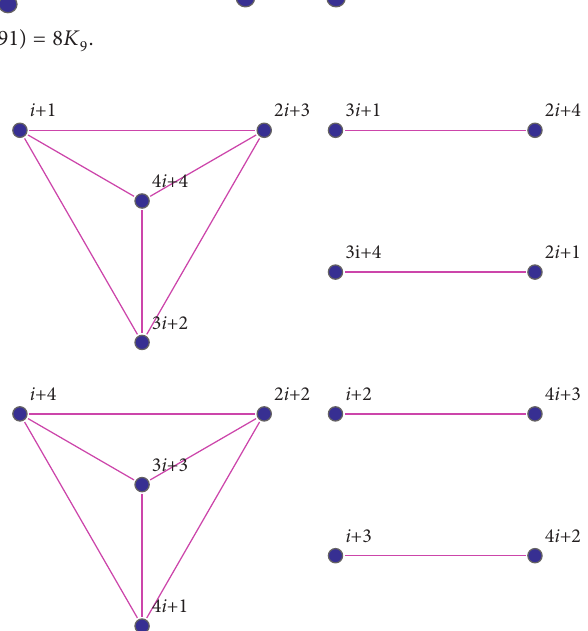
Figure 2: 􏽢 G ( 3 , 91 ) � 8 K